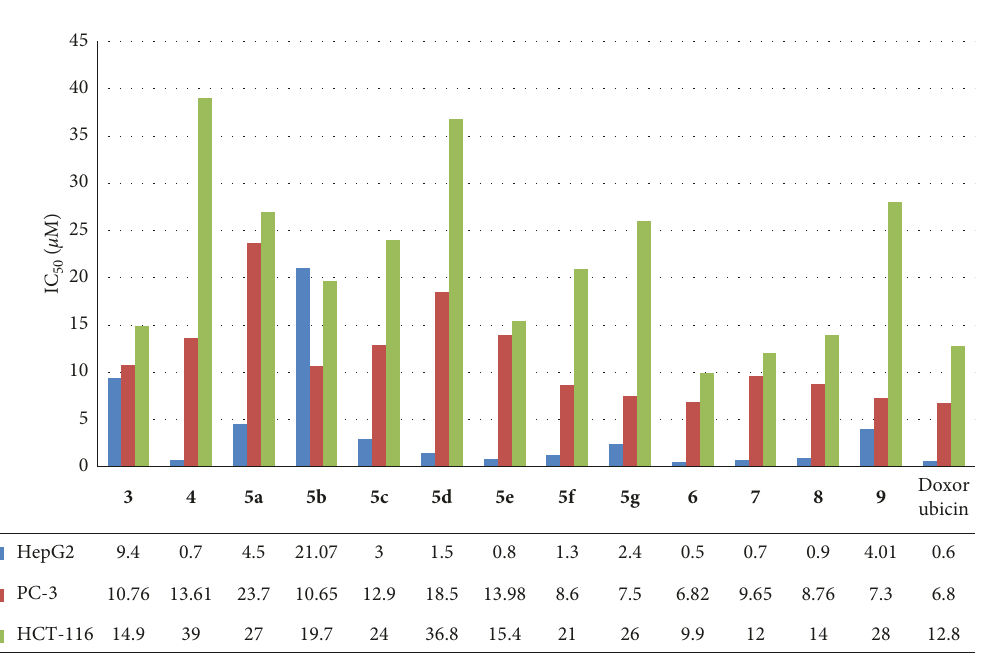
Figure 2: Percentage of growth inhibition activity against cancer cell lines at 100 μ M dose.